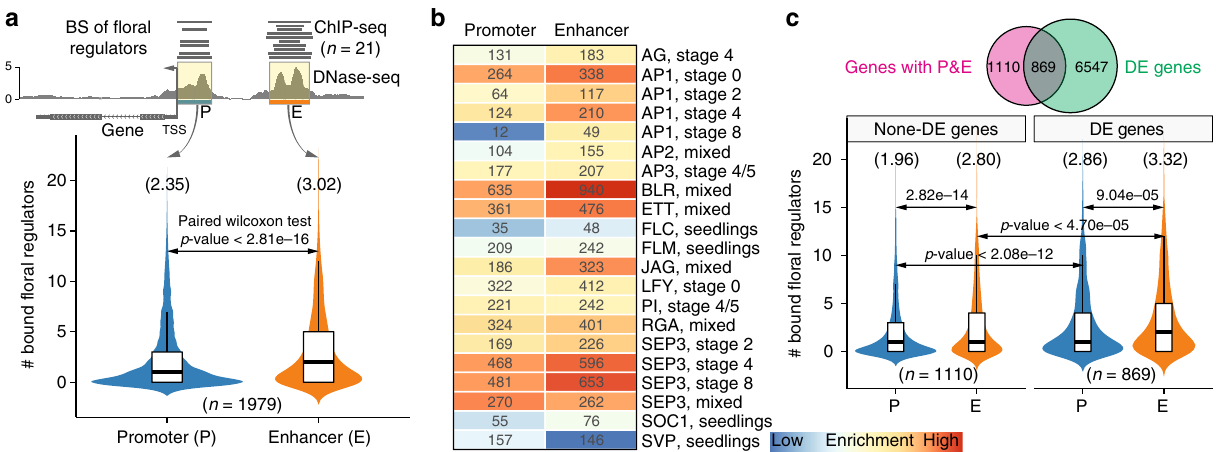
Fig. 5 Enhancers show more enrichment in binding sites of fl oral regulators than promoters. a Violin plots (with boxplots inside) showing the number of transcription factor binding sites in promoters (P) and enhancers (E). The above diagram shows the strategy used in the analysis. Only genes with both promoters and enhancers were considered. Twenty one ChIP-seq datasets for 15 fl oral regulators were included in the analysis (data from ref. 48 ). The numbers in the parentheses above the plots indicate the average value in each category. Boxplots show the median (horizontal line), second to third quartiles (box), and Tukey-style whiskers (beyond the box). BS binding sites. b Heatmap showing the enrichment of binding sites of different regulators in promoters and enhancers, respectively. Enrichment scores were calculated as log10(p-value) based on hypergeometric tests, using all the annotated protein-coding genes as the background. Numbers indicate the number of proximal genes in each category. c Similar to a , analysis was performed respectively on differentially expressed (DE) genes and non-DE genes during fl ower development. The Venn diagram above shows signi fi cant overlap (hypergeometric test, p -value < 1.92e – 64) between genes having promoters/enhancers and genes exhibiting differential expression. The underlying source data for a and c are provided in the Source Data fi